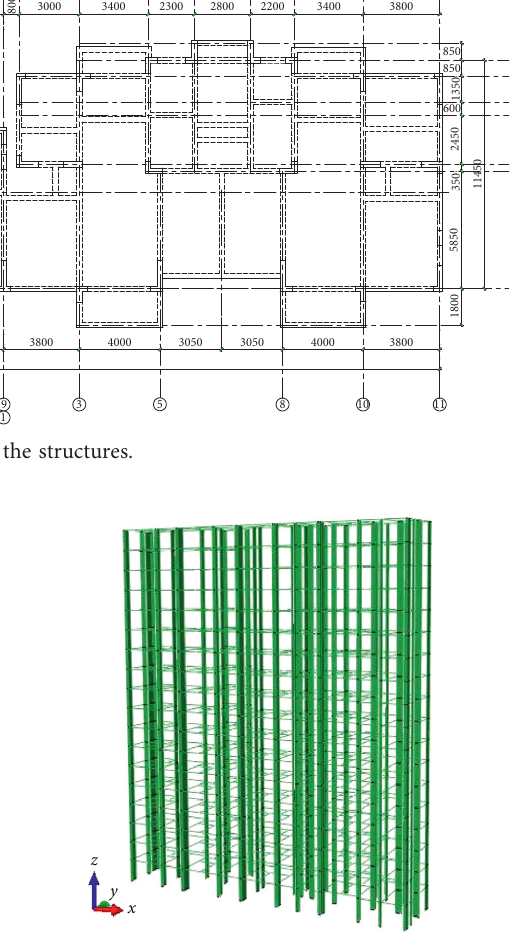
Figure 14: Finite element model used in